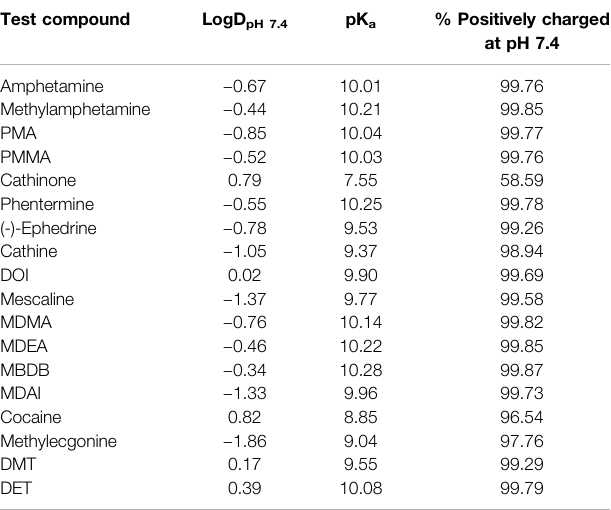
TABLE 1 | Physicochemical properties of investigated psychoactive compounds (predicted using MarvinSketch, version 19.8, ChemAxon, Budapest,